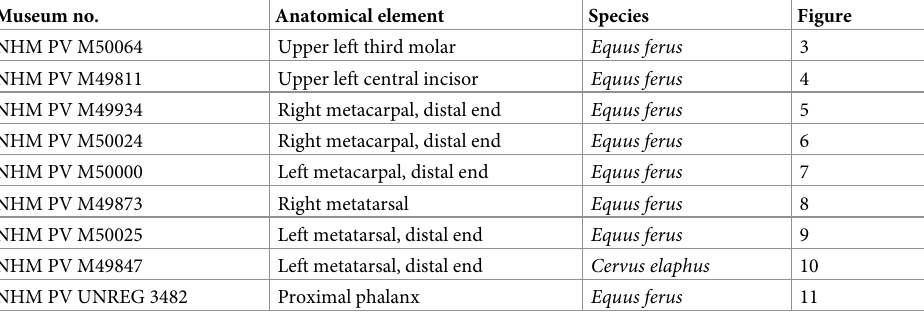
Table 1. List of teeth and bones from Gough’s Cave used as knapping tools. Museum no. Anatomical element Species